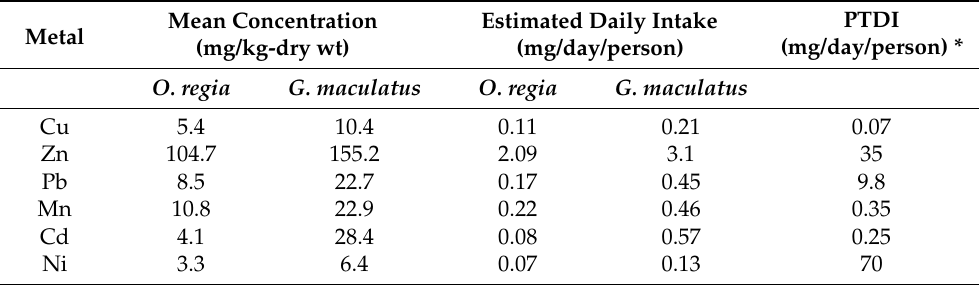
Table 4. A comparative account of the estimated daily intake of heavy metals from O. regia and G.